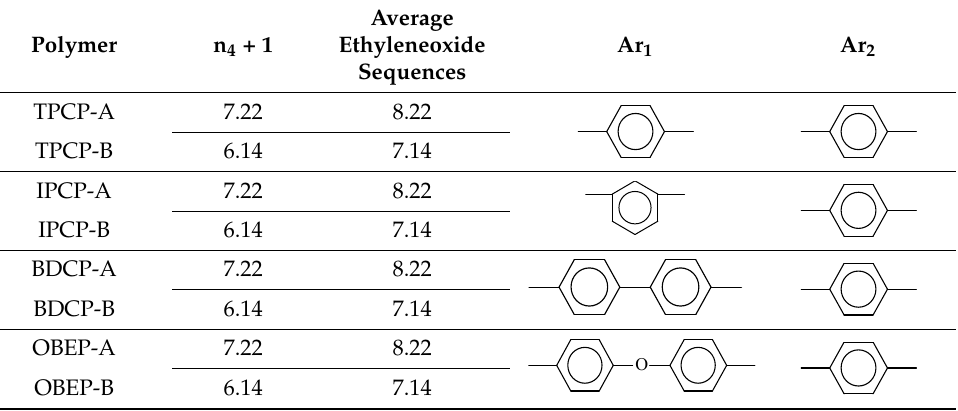
Table 1. Structure of the synthesized polymers.